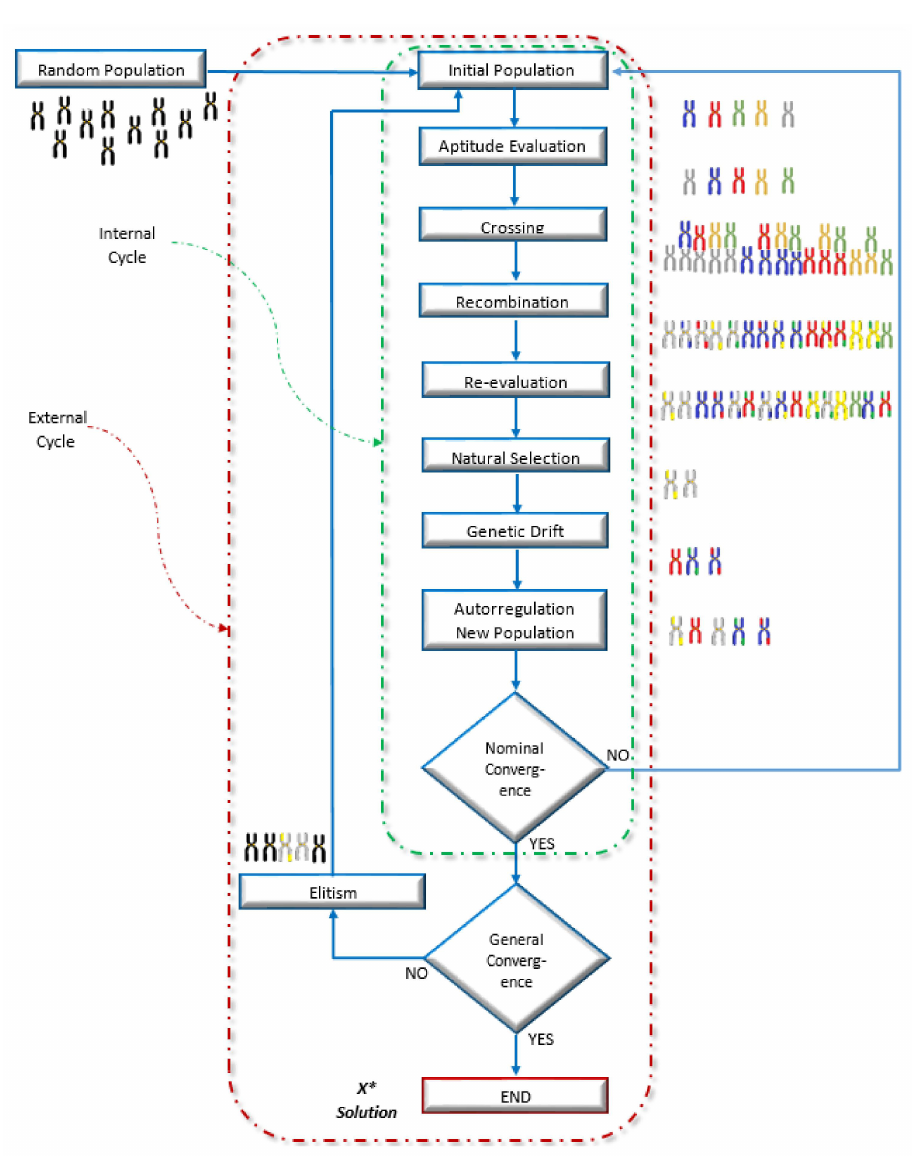
Figure 3. Genetic micro-algorithm fitness evaluation. The algorithm begins generating a random population of five sets of movements, which are named individuals. Then, this population is evaluated based on its